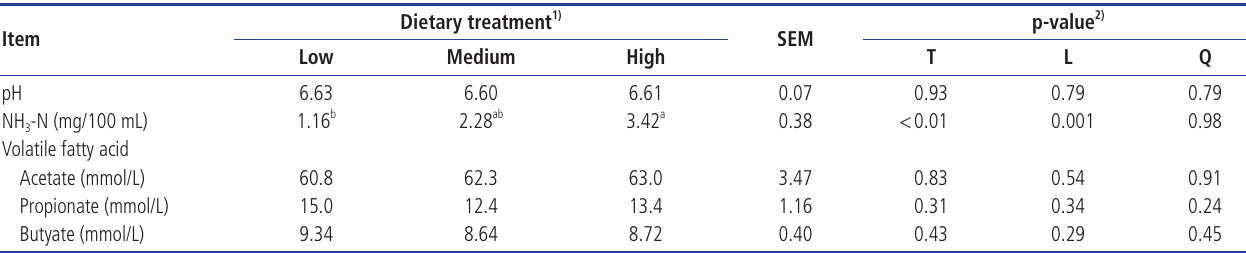
Dietary treatment 1)